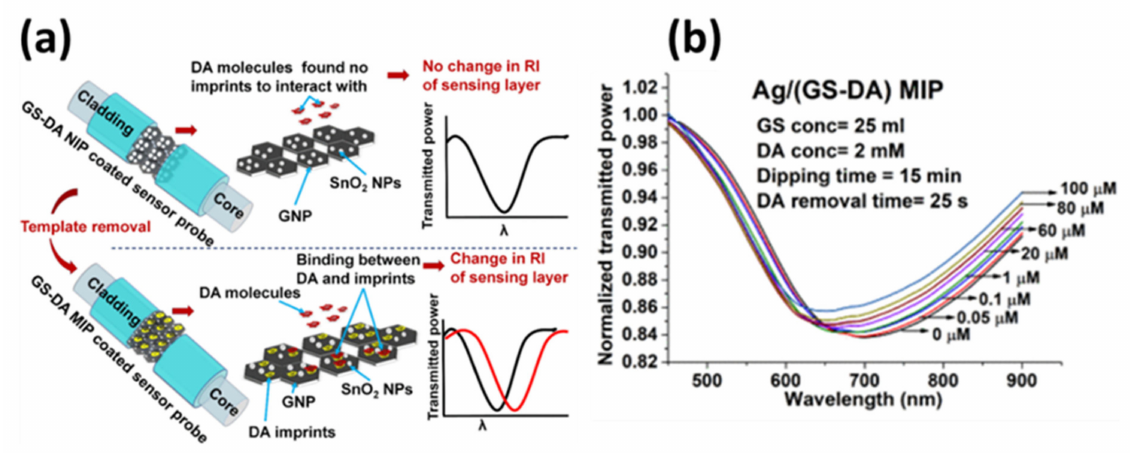
Figure 25. ( a ) Sensing mechanism, and ( b ) SPR response of fiber optic DA sensor utilizing GNP@SnO 2 nanocomposite as MIP host matrix. Reprinted with permission from Ref. [104]. Copyright 2018 IEEE.